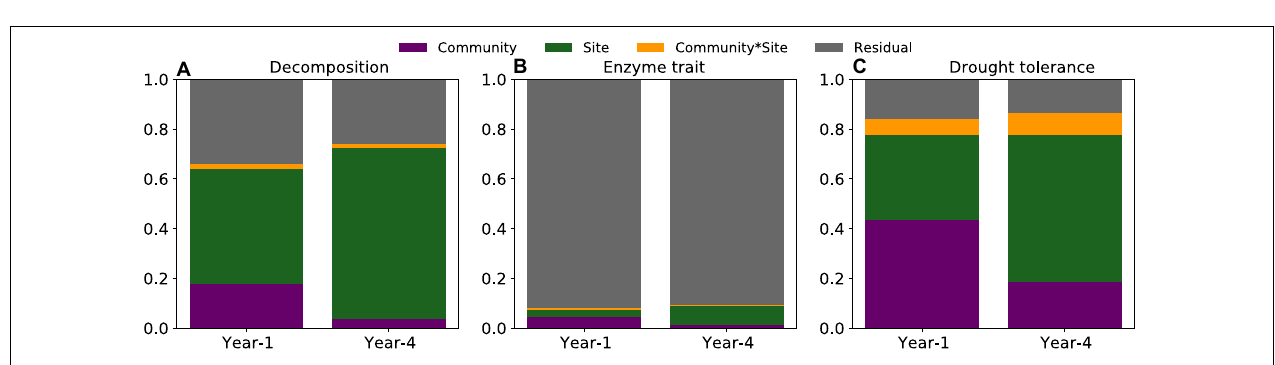
FIGURE 3 | Variance partitioning of decomposition (A) , enzyme trait (B) , and drought tolerance (C) . For the enzyme trait (B) only community and site are significant in year 1, and only site is significant in year 4. These results are under the average